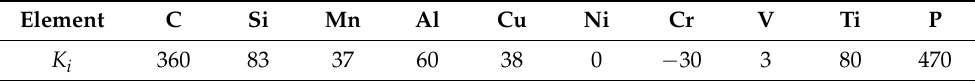
Table 3. Yield strength increment K i of solid solution elements per 1% mass fraction in ferrite, MPa. Element C Si Mn Al Cu